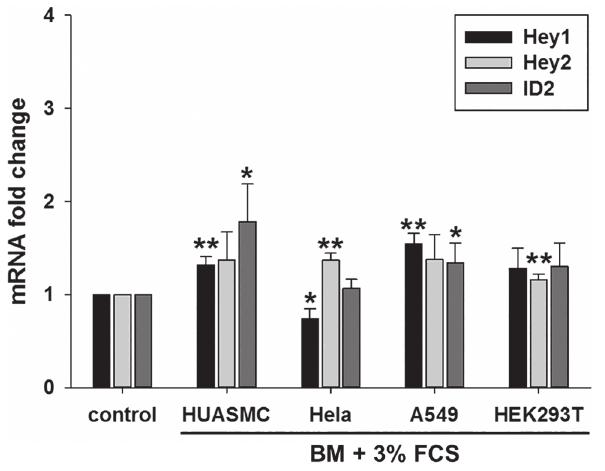
Fig 5. Marginal activation of Hey1 , Hey2 and ID2 in non-endothelial cells. HUASMC, Hela, A549 and HEK293T cells were cultured in their standard medium, before they were left untreated or the medium was changed to basal medium containing 3% FCS. The transcript levels of Hey1 , Hey2 and ID2 were determined 1.5h after changing the medium and were normalized to the samples, whose medium was not changed. Mean and standard deviation, n = 3, * p < 0.05, ** p <